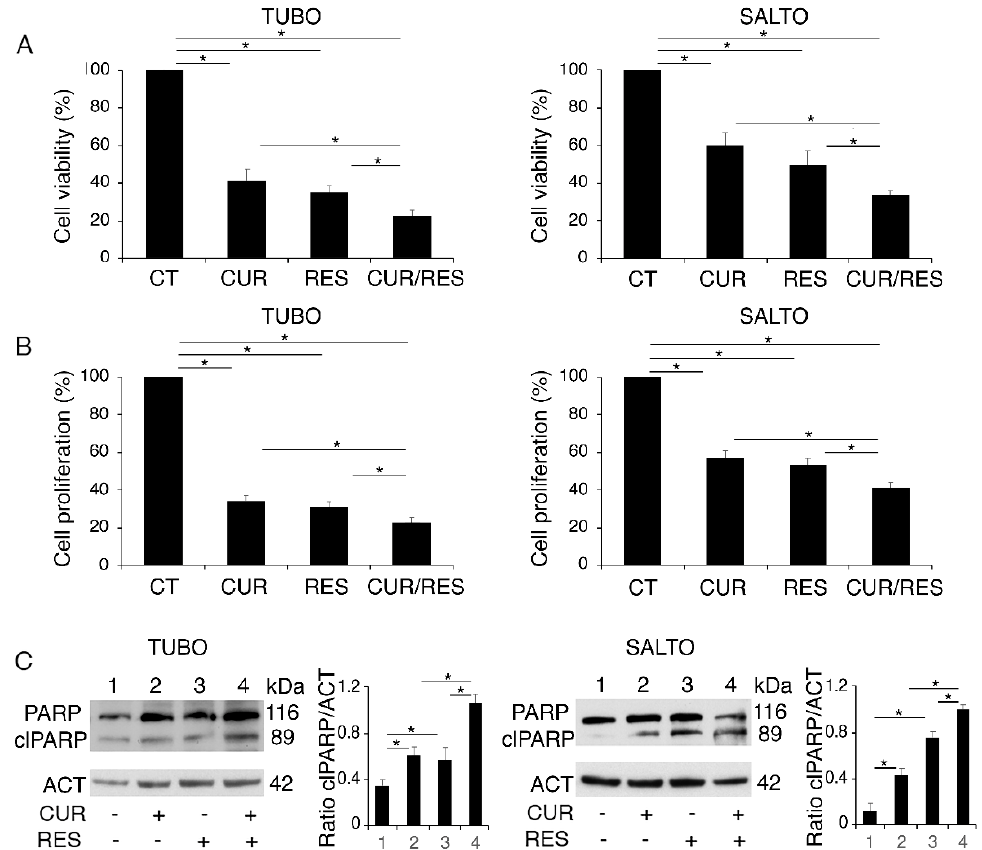
Figure 1. Curcumin (CUR), resveratrol [9] and their combination (CUR/RES) induce a cytotoxic effect in TUBO and SALTO cell lines. TUBO and SALTO cells were untreated (CT) or treated with curcumin (15 µ M), resveratrol (15 µ M) or combination of both for 48 h, and ( A ) cell survival and ( B ) cell proliferation were evaluated by trypan blue and MTT assays, respectively. Histograms represent the mean plus standard deviation (S.D.) of three independent experiments. ( C ) Western blot analysis showing cleavage PARP (clPARP) in TUBO and SALTO cells treated with curcumin, resveratrol or combination of both, as above reported. Histograms represent the mean plus S.D. of densitometric analysis of three independent experiments. Actin was used as loading control (ACT). One representative experiment is shown. * p value <0.05.